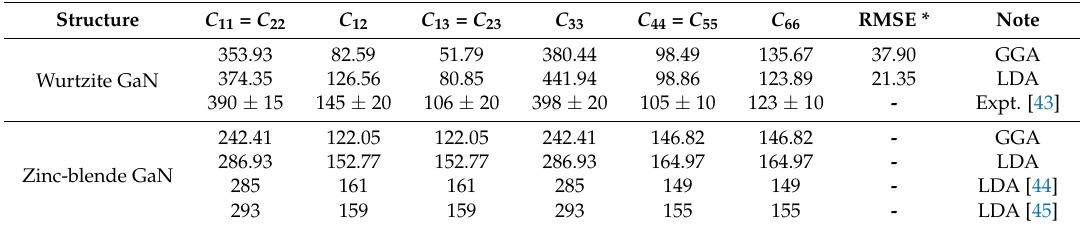
Table 2. Calculated elastic constant C ij , GPa.